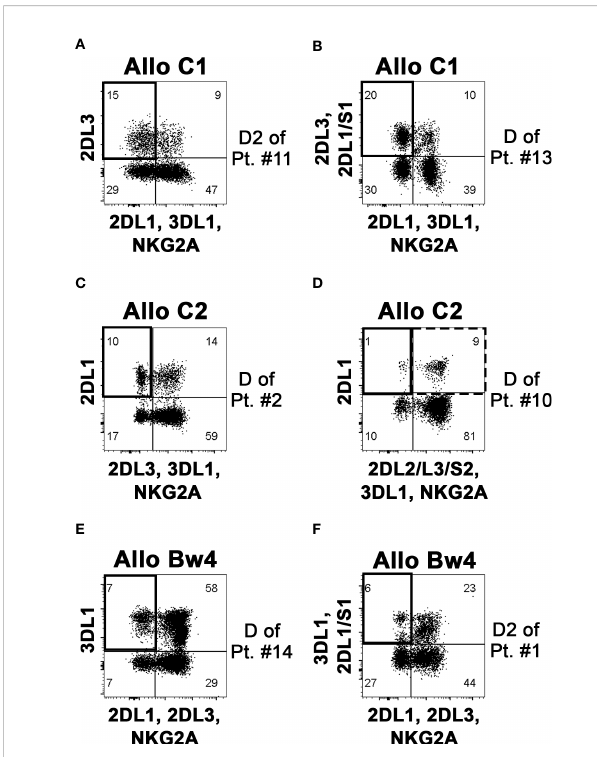
FIGURE 3 Identi fi cation and quanti fi cation of the alloreactive NK cell subset on donor PBMC. By fl ow-cytometry, NK cells (gating on CD3 – CD56 + cells of PBMC) were analyzed to de fi ne the size of the alloreactive subset (indicated as a square in upper left quadrants). Representative donors characterized to be Allo C1 (A, B) , Allo C2 (C, D) , and Allo Bw4 (E, F) , considering the KIR-L present in the donor and missing in the recipient and the presence of donor iKIR speci fi c for the mismatched KIR-L, are shown. Three donors were without ( A, C, E ), and three donors with the relevant aKIR (B, D, F) as indicated in Table 2. The presence of KIR2DS2 can determine an underestimation of the alloreactive NK cell subset, as shown for the Allo C1 donor of patient #10 (D) ; the square with a dashed line (upper right quadrant) includes the possible presence of alloreactive KIR2DL1 + KIR2DS2 + cells that cannot be properly